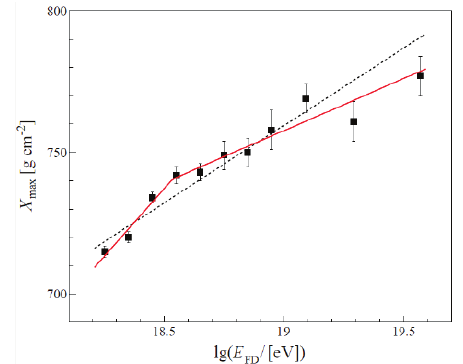
Fig.3a. X max vs Energy from the Black Rock/Long Ridge Observations by the Telescope Array Collaboration. The dashed line is a fit to the points with a single straight line (Elongation Rate = 54 ± 3 g cm -2 /decade). The full line is a fit with a break and the best-fit straight lines found simultaneously. The Elongation Rate above the break at 3 EeV is 37 ± 5 g cm -2 /decade. See [2] for further discussion.